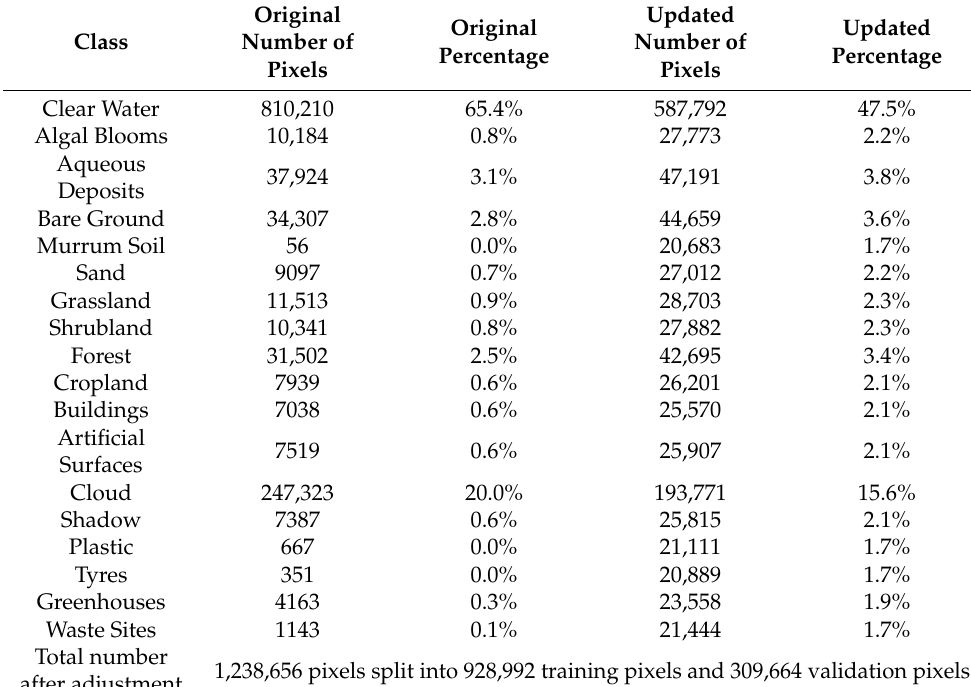
Table 4. Training sample distribution amongst the classes. Class